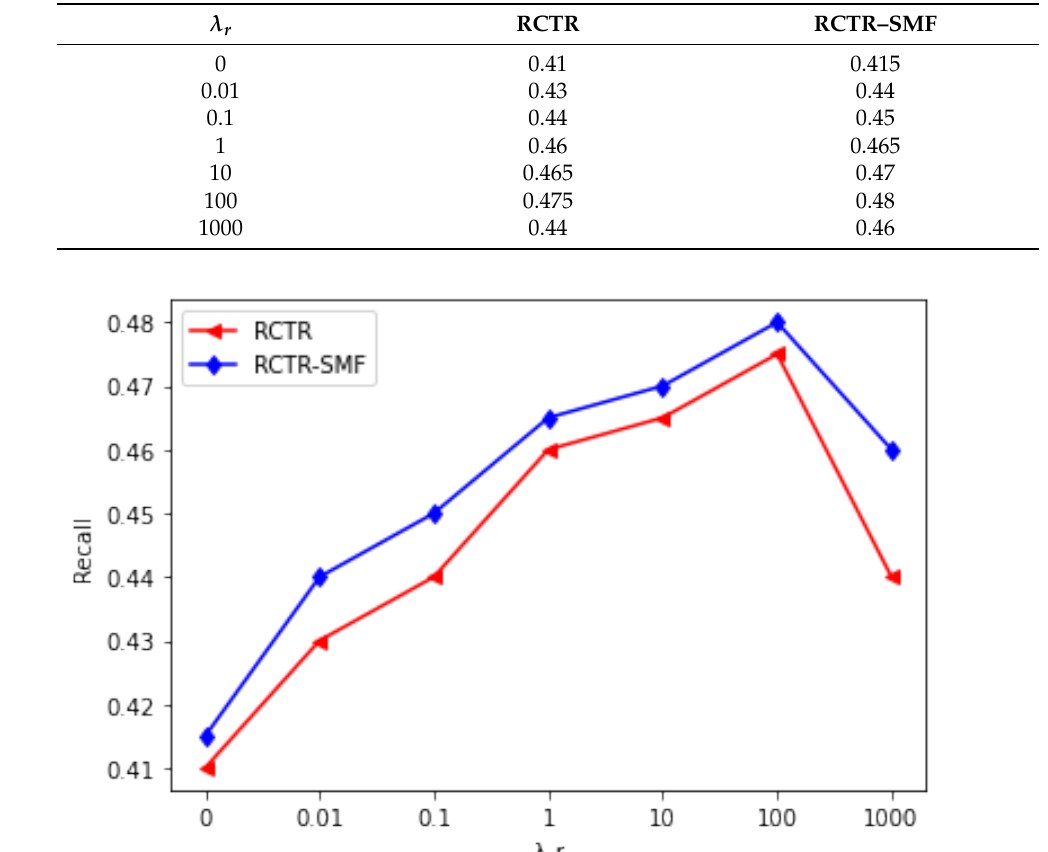
is varied, but and are kept 𝜆𝜆 𝑟𝑟 𝜆𝜆 𝑣𝑣 𝜆𝜆 𝑞𝑞